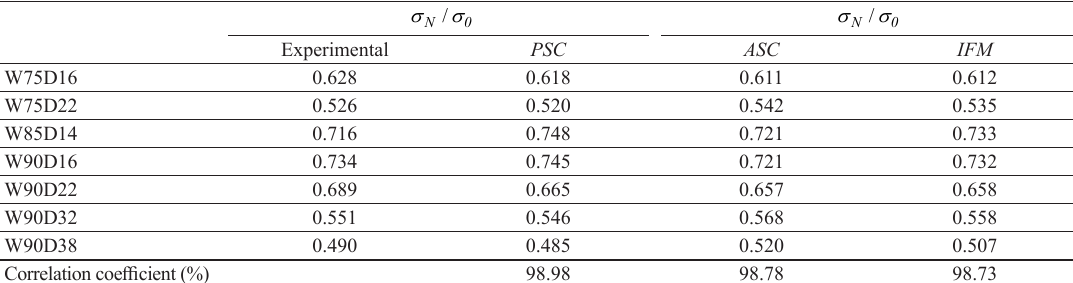
Figure 4. Comparison between the adapted PSC method proposed by Equation 18 and the experimental data. ) in relation to stress on the material without hole (σ ) obtained from Equation 18 for the three methods Table 5. Residual stress ratio (σ N 0 (PSC, ASC and IFM) compared to the experimental values and their respective correlation